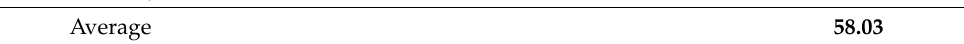
Table 1. Scaled Mooring Line Mass.